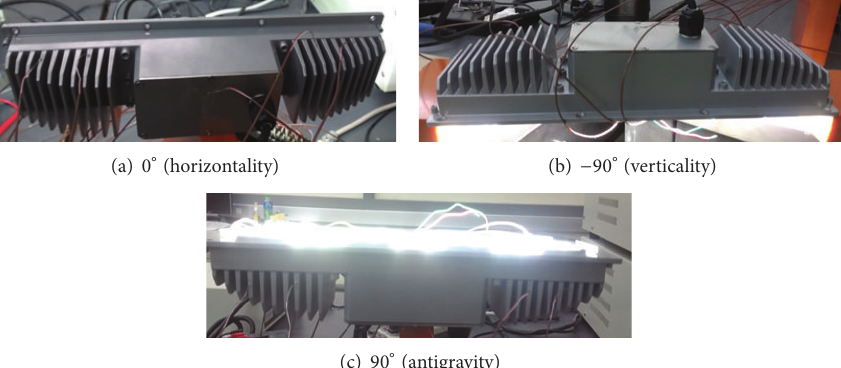
Figure 4: Three inclined angles.